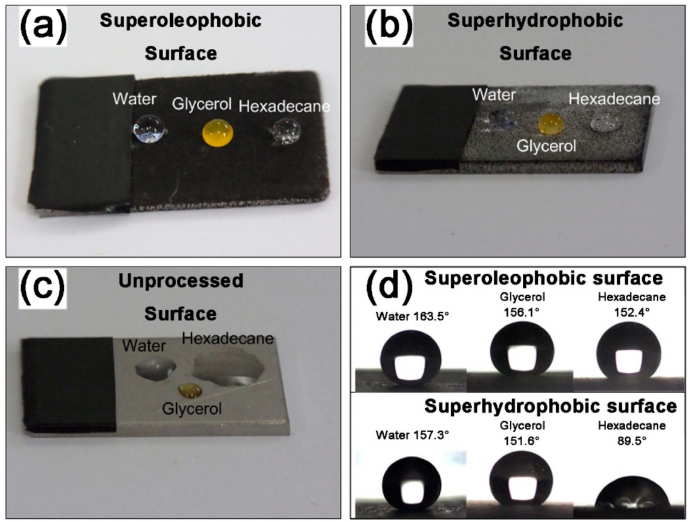
Figure 11. ( a – c ) Images of water droplets on the surface of superoleophobic Ti surface, super-hydrophobic Ti surface, and unprocessed Ti surface, respectively; ( d ) Variations in contact angles of super-oleophobic and super-hydrophobic Ti surface. Reprinted with permission from [78]. Copyright (2013) American Chemical Society.